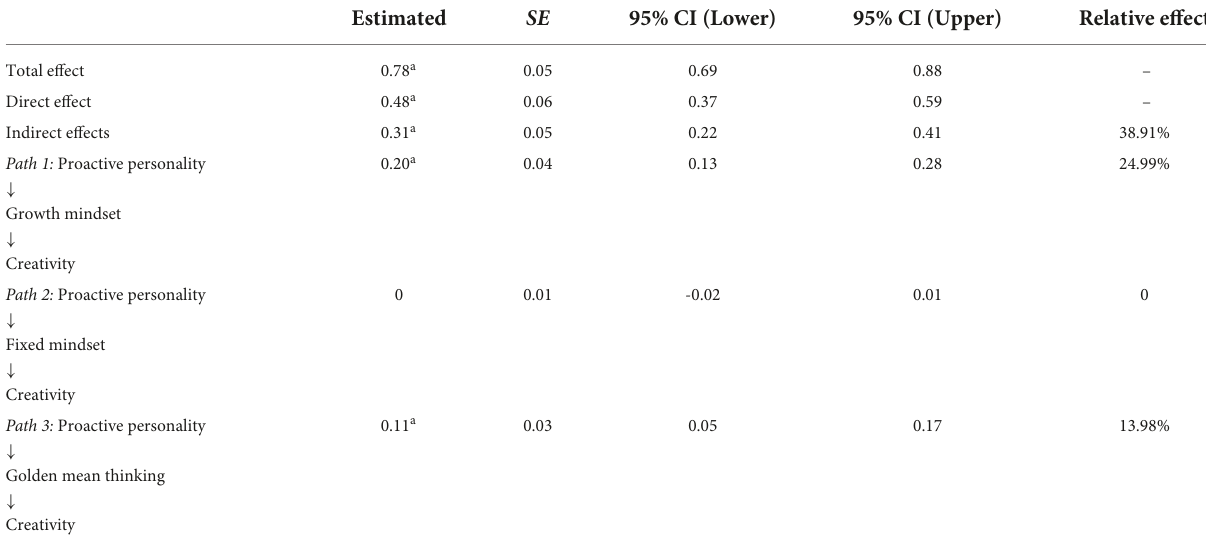
TABLE 2 Direct and indirect effects of proactive personality on creativity through growth mindset, fixed mindset, and golden mean thinking (three pathways for indirect